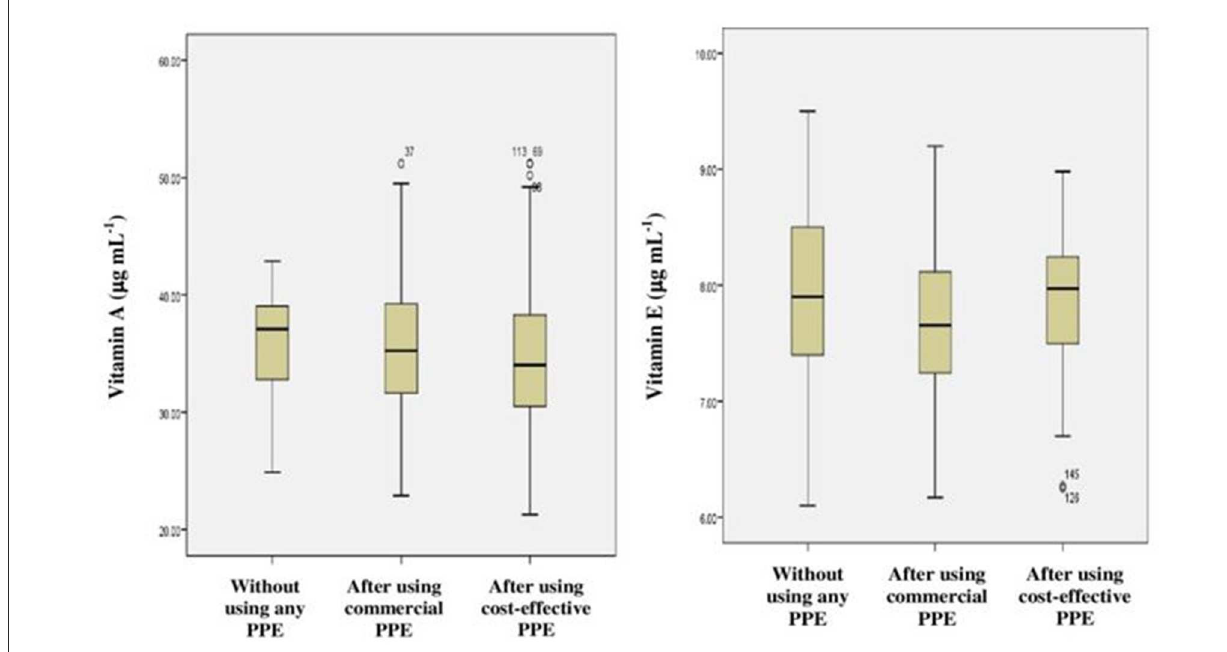
FIGURE6 Frequency distribution (Box-plots) for nutrients among farm-workers not using and after their use of